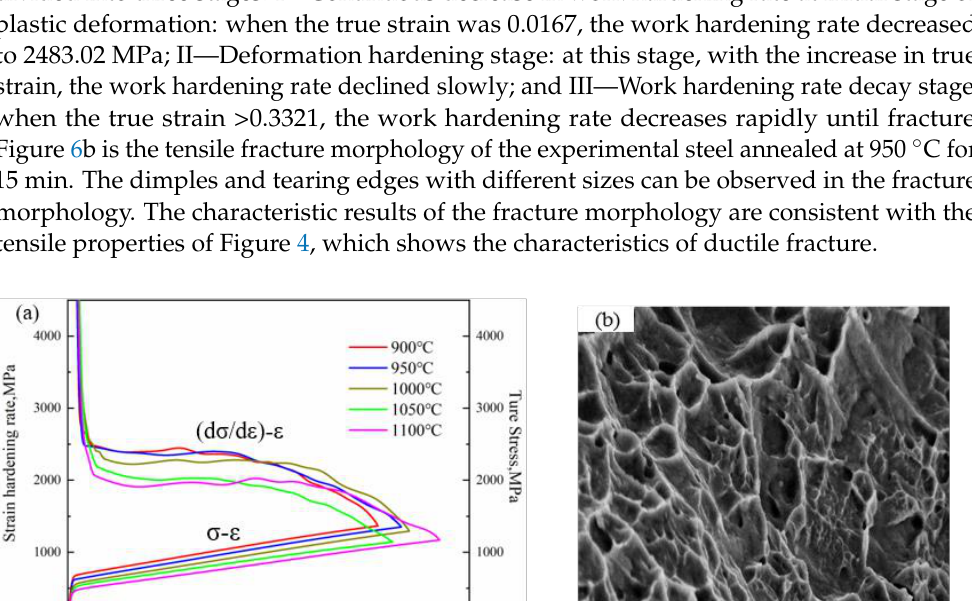
Figure 7. TEM images of the experimental steel after fracture at different annealing temperatures. ( a ) 900 °C; ( b ) 950 °C; and ( c ) 1000 °C In order to further study the deformation behavior and deformation process of the experimental steel, tensile tests with different deformations were carried out on the 950 °C annealed experimental steel. It can be seen from Figure 8 that slip occurs on {111} plane. Figure 8a,b is the TEM image of the experimental steel with deformation of 5%. Through the image, it can be observed that the dislocation structure of the experimental steel at low deformation is plane slip dislocation, and some basic dislocation structures can also be